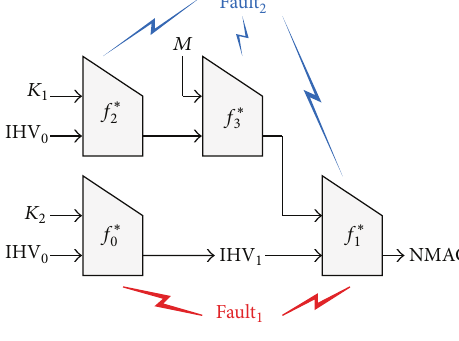
Figure 3: Our fault model on